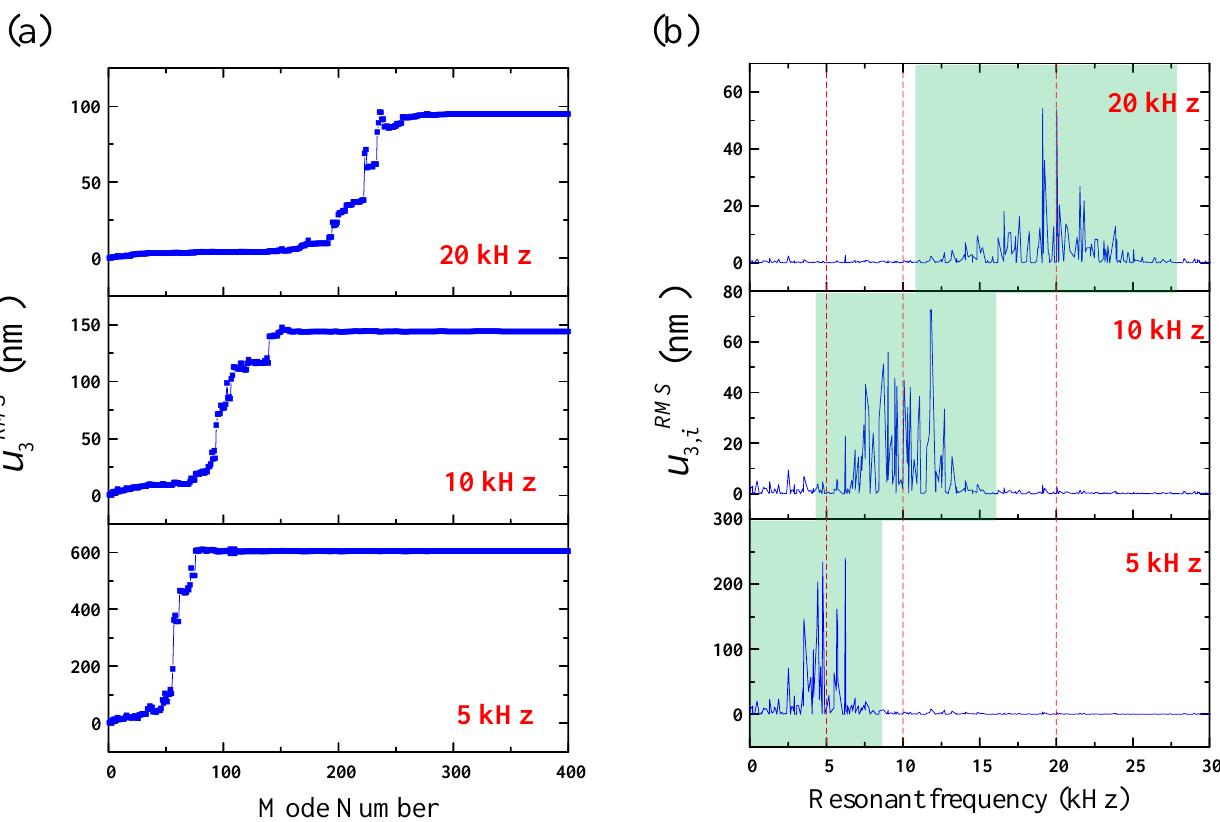
Figure 2. ( a ) The relation between the root-mean-square (RMS) transient displacement and the required number of vibrational modes. ( b ) The relation between the RMS transient displacement due to the i th mode and the resonant